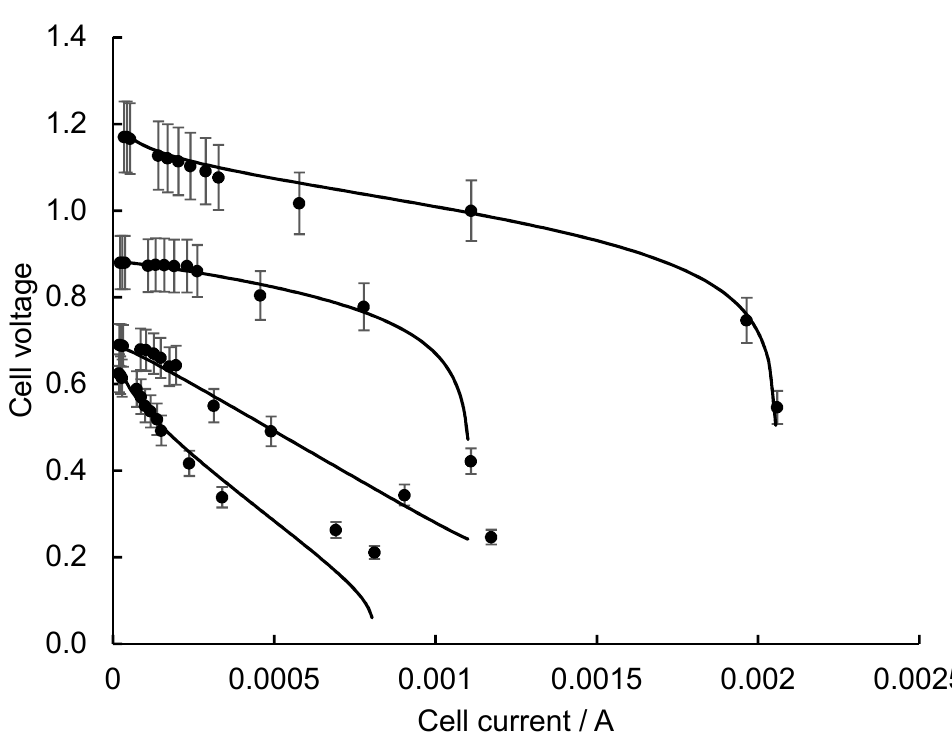
Figure 2. Polarization curves at different pH values (from top to bottom: pH 2, pH 4, pH 6, and pH 8) of an SMFC; experimental data ( • ) and their corresponding predictions (solid black line). Anode: 2 pieces of CF; anolyte: PCS + 3 g of kerosene. Cathode: birnessite/CF; catholyte of 0.8 M Na 2 SO 4 .